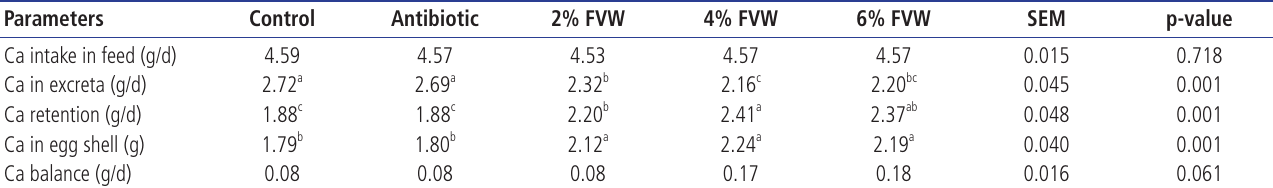
Table 3. Effect of Flammulina velutipes mushroom stem waste (FVW) on calcium utilization in layer 1)